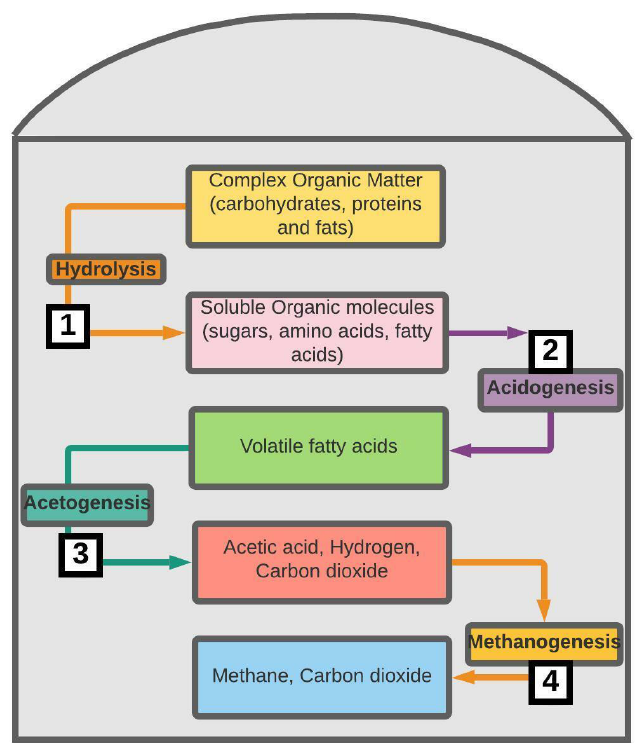
Figure 3. Anaerobic digestion stages in an anaerobic reactor.